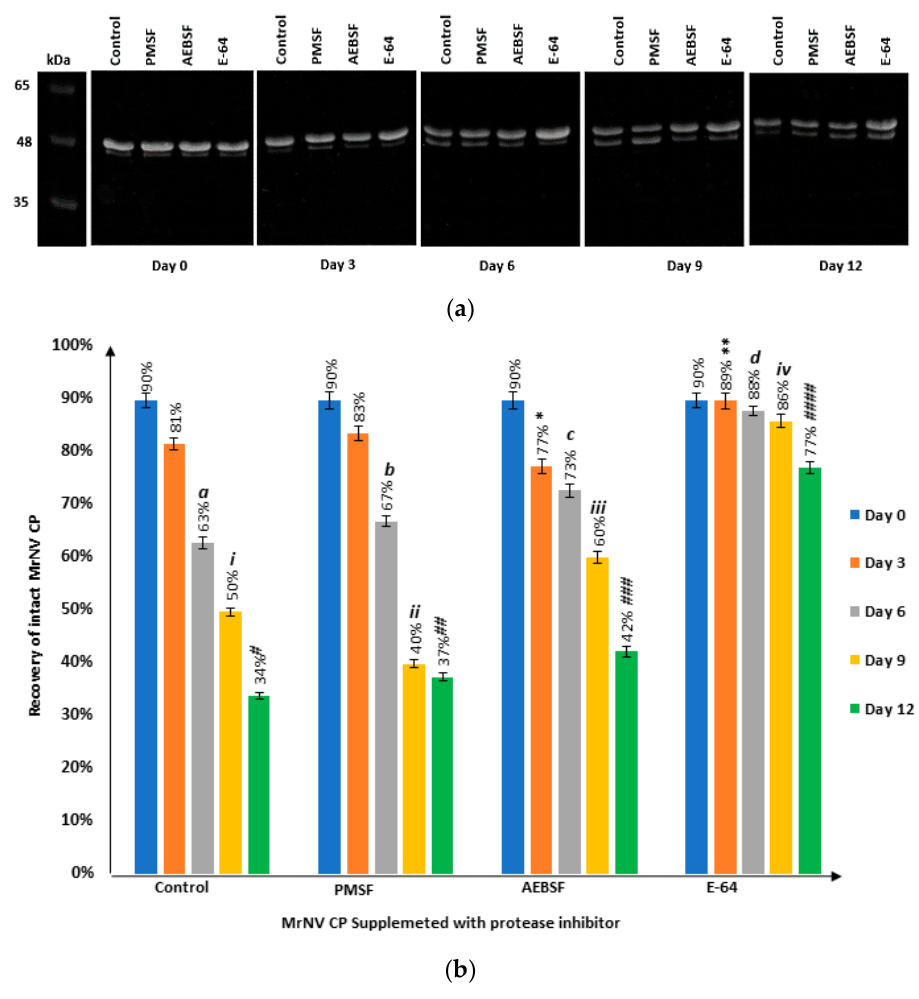
Figure 4. Degradation rate profiles of MrNV CP on days 0, 3, 6, 9 and 12. ( a ) Protein degradation rate analysis of MrNV CP. Protein markers in kDa are indicated at the left. Control indicates the MrNV CP untreated with inhibitors. The protease inhibitors added are labelled on top of each lane. ( b )